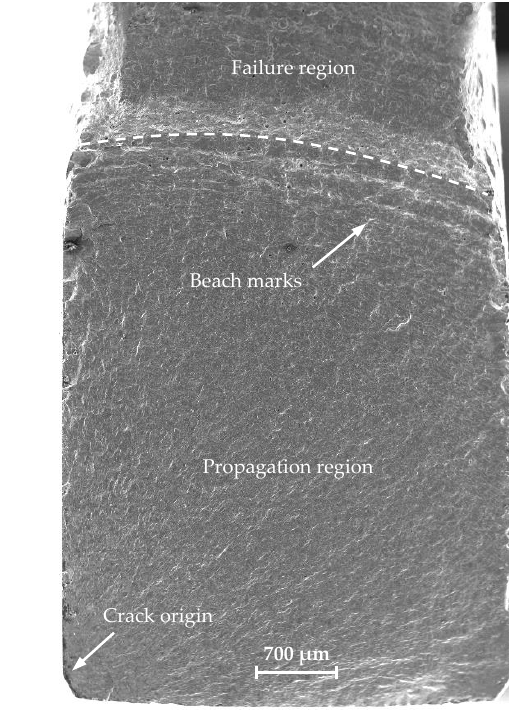
Figure 13. Location of crack origin for: ( a ) S235JR steel; ( b ) 1.4301 steel.